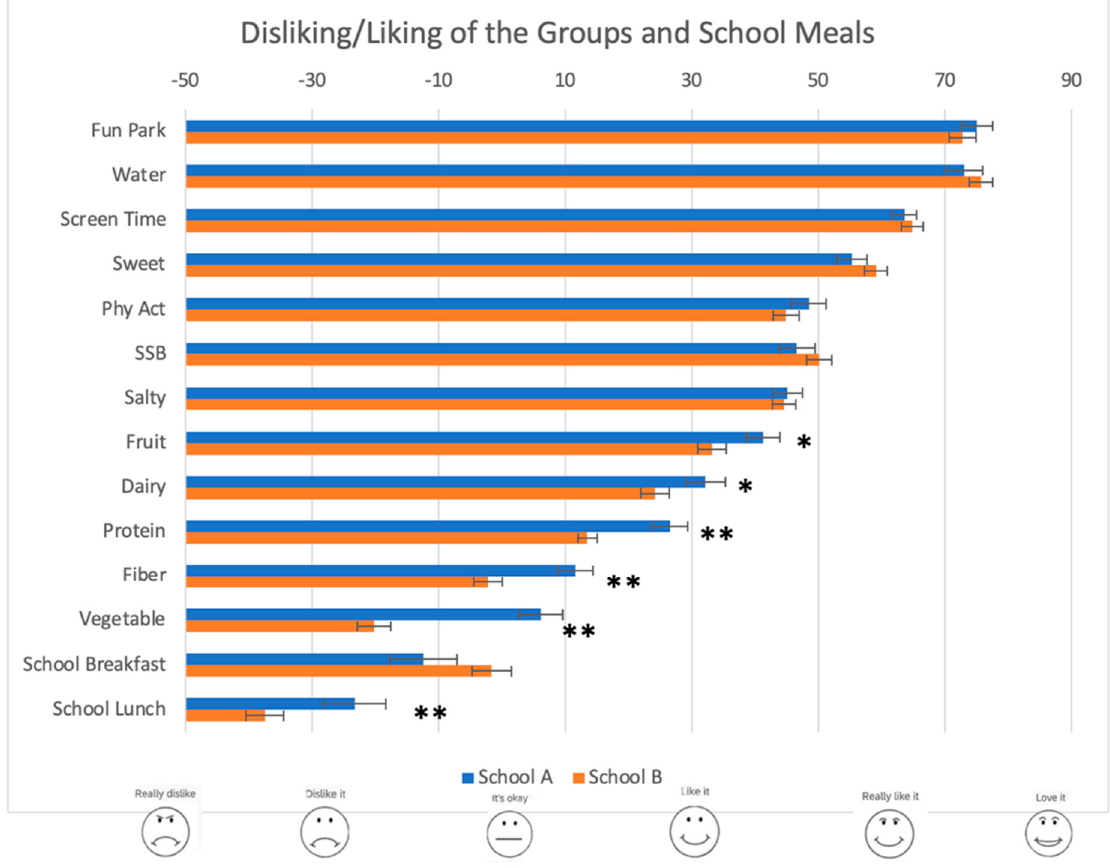
Figure 1. Students’ average reported liking of foods and behaviors at both schools. The * indicates p < 0.05; School B had significantly lower liking of healthier groups (protein, fiber, and vegetables).